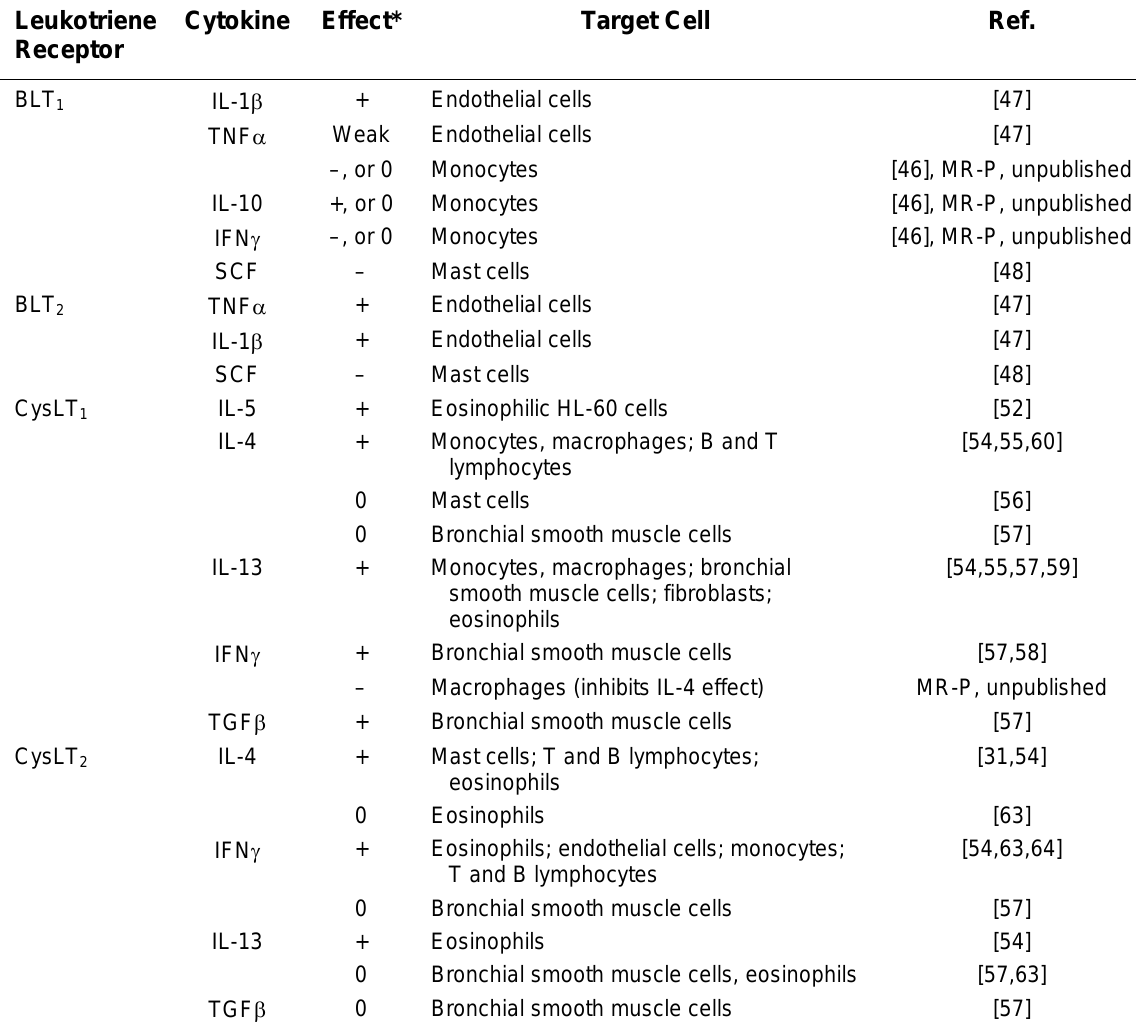
Cytokine-Induced Modulation of Leukotriene Receptor Expression